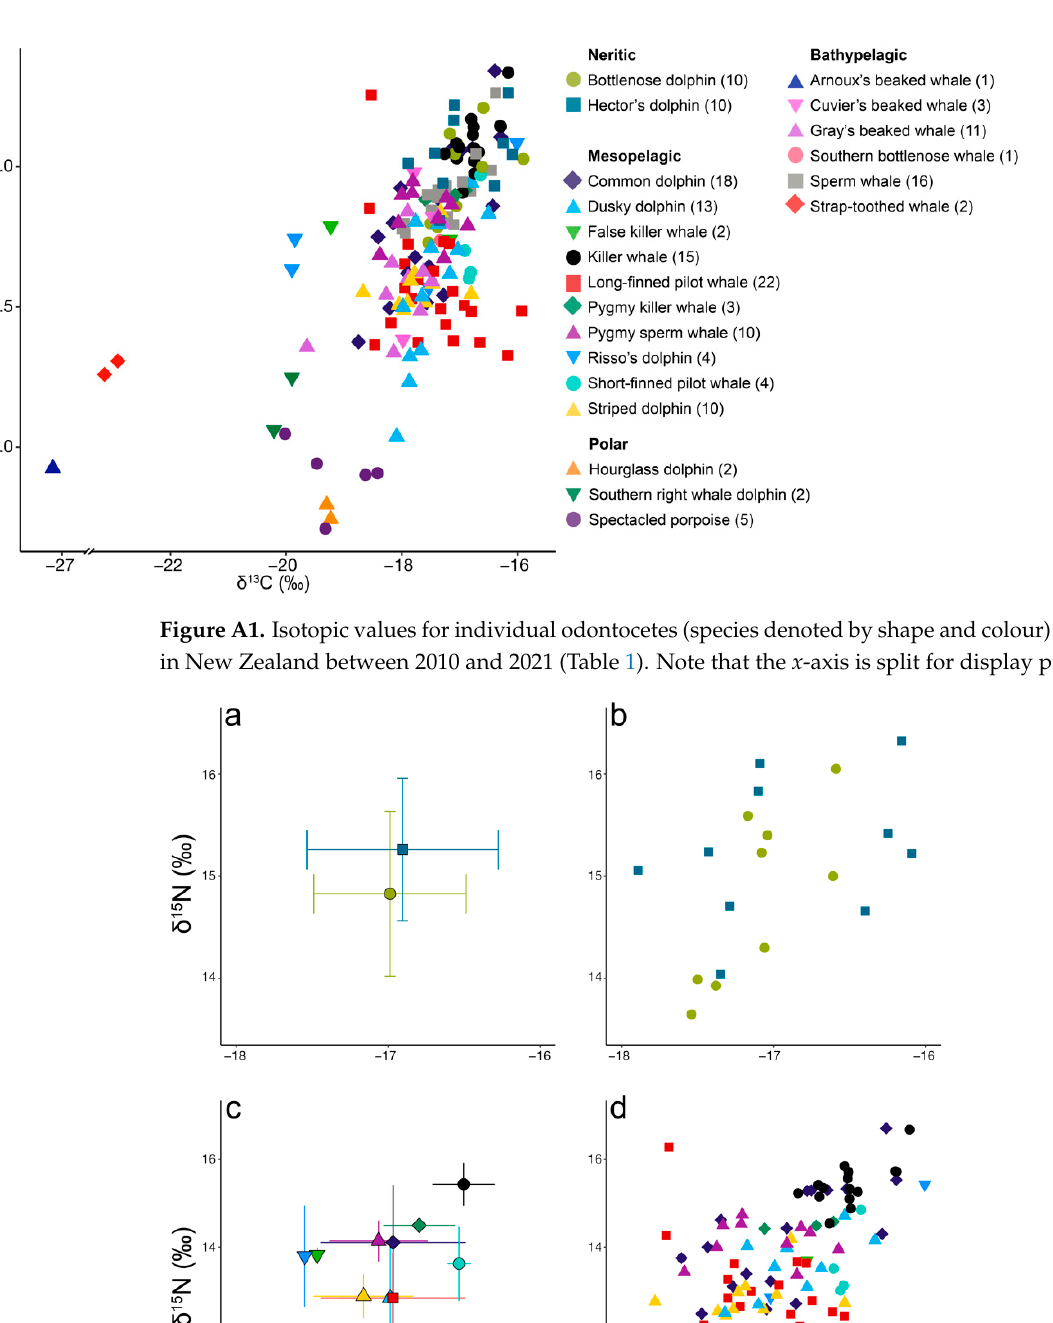
Figure A2. Isotopic values for individual odontocetes stranded in New Zealand between 2010 and 2021 displayed by habitat (Table 1) for ( a , b ) neritic odontocetes, ( c , d ) mesopelagic odontocetes, ( e , f ) bathypelagic odontocetes, and ( g , h ) polar odontocetes. Species denoted by shape and colour, (for legend see Figure A1).